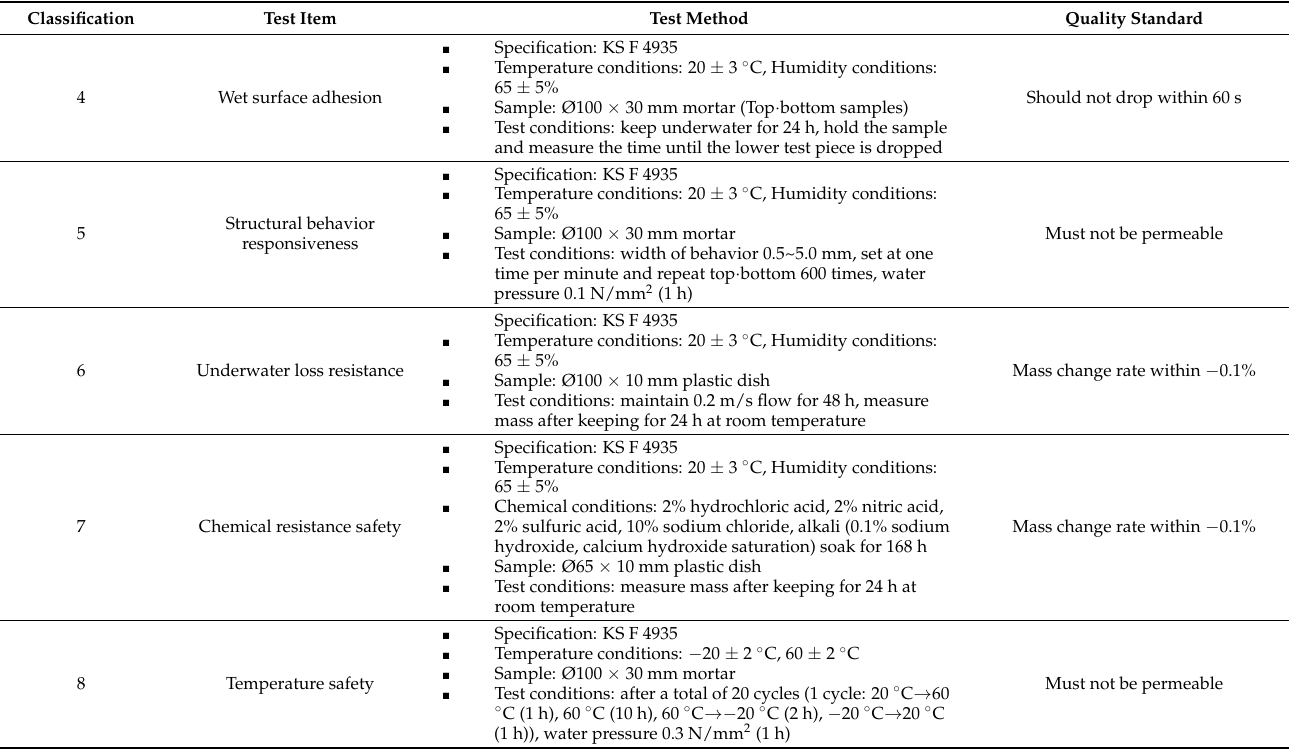
Figure 6. Variation in viscosity with melting time. 3.1.2. Viscosity As shown in Figure 7, the viscosity value by ratio of molten liquid material extracted at 190 °C and 60 min by the ratio of waste oil and waste rubber showed that an equivalent waste oil content was impossible based on the waste rubber content, and the lower the content of waste oil, the higher the viscosity.